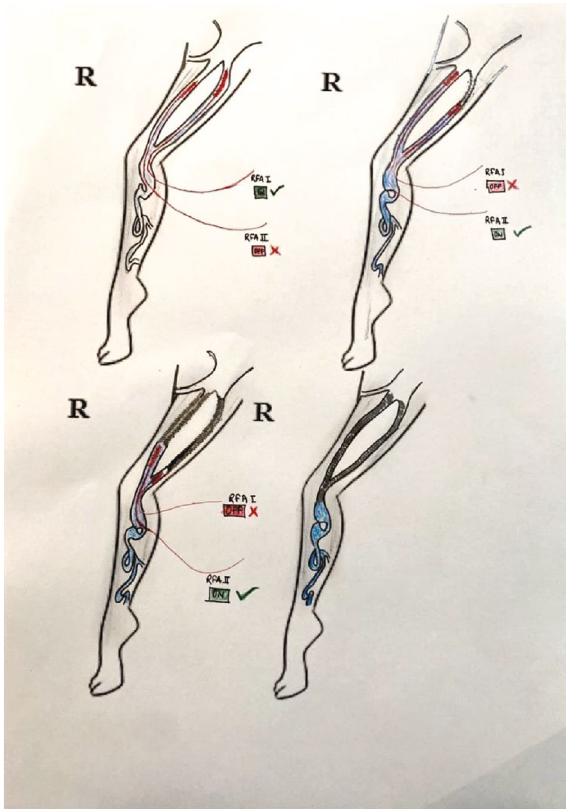
Figure 2: Double great saphenous vein with an alternating RFA technique.